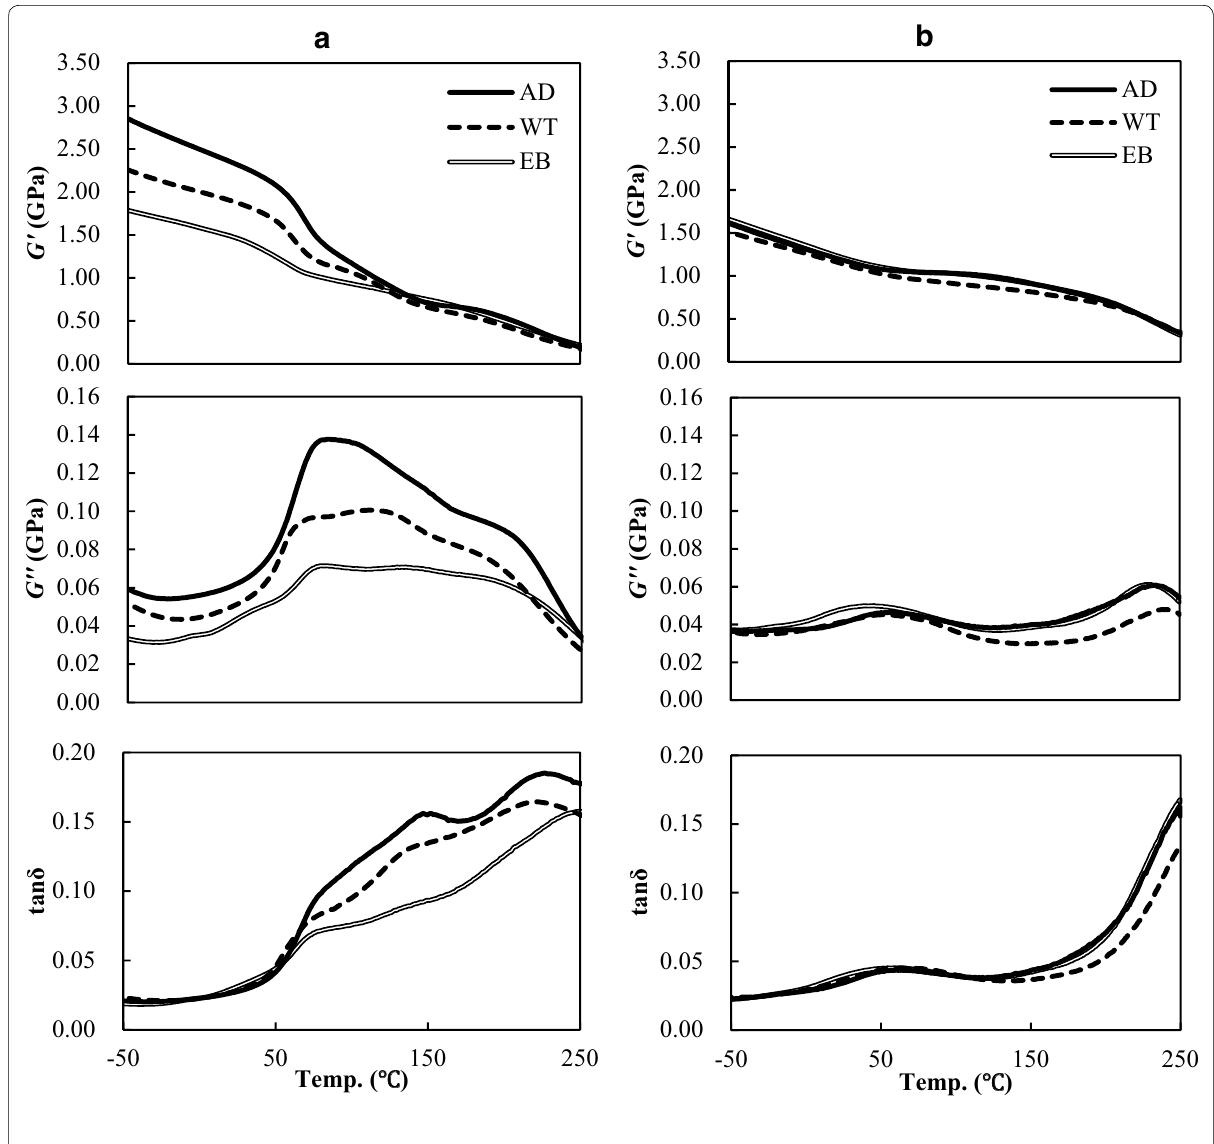
Fig. 10 Temperature dependence of the dynamic viscoelasticity among extraction treatments in a heartwood and b sapwood